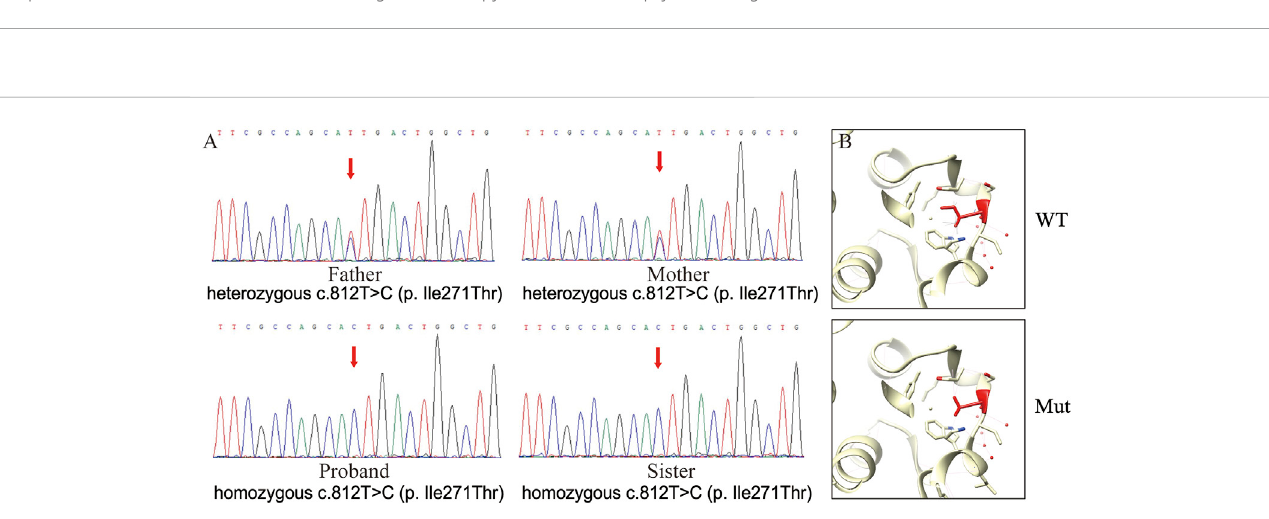
FIGURE 2 MutationanalysesoftheLSSgene. (A) .Partialsequencesof LSS NM_002340.6(LSS_v001):c.812T > C(p.(Ile271Thr))mutation.Theredarrowindicatesthe mutation site. (B) . 3D modeling of the impact of the LSS nonsense mutation. The red amino acid indicates the mutation